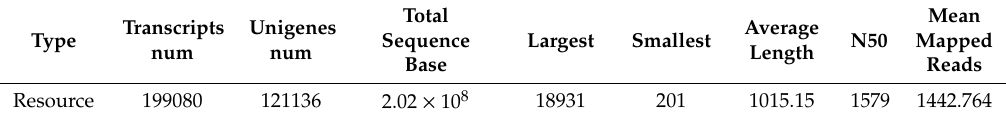
Table 2. Statistics for the transcriptome assemblies derived from P. acerifolia leaf RNA.